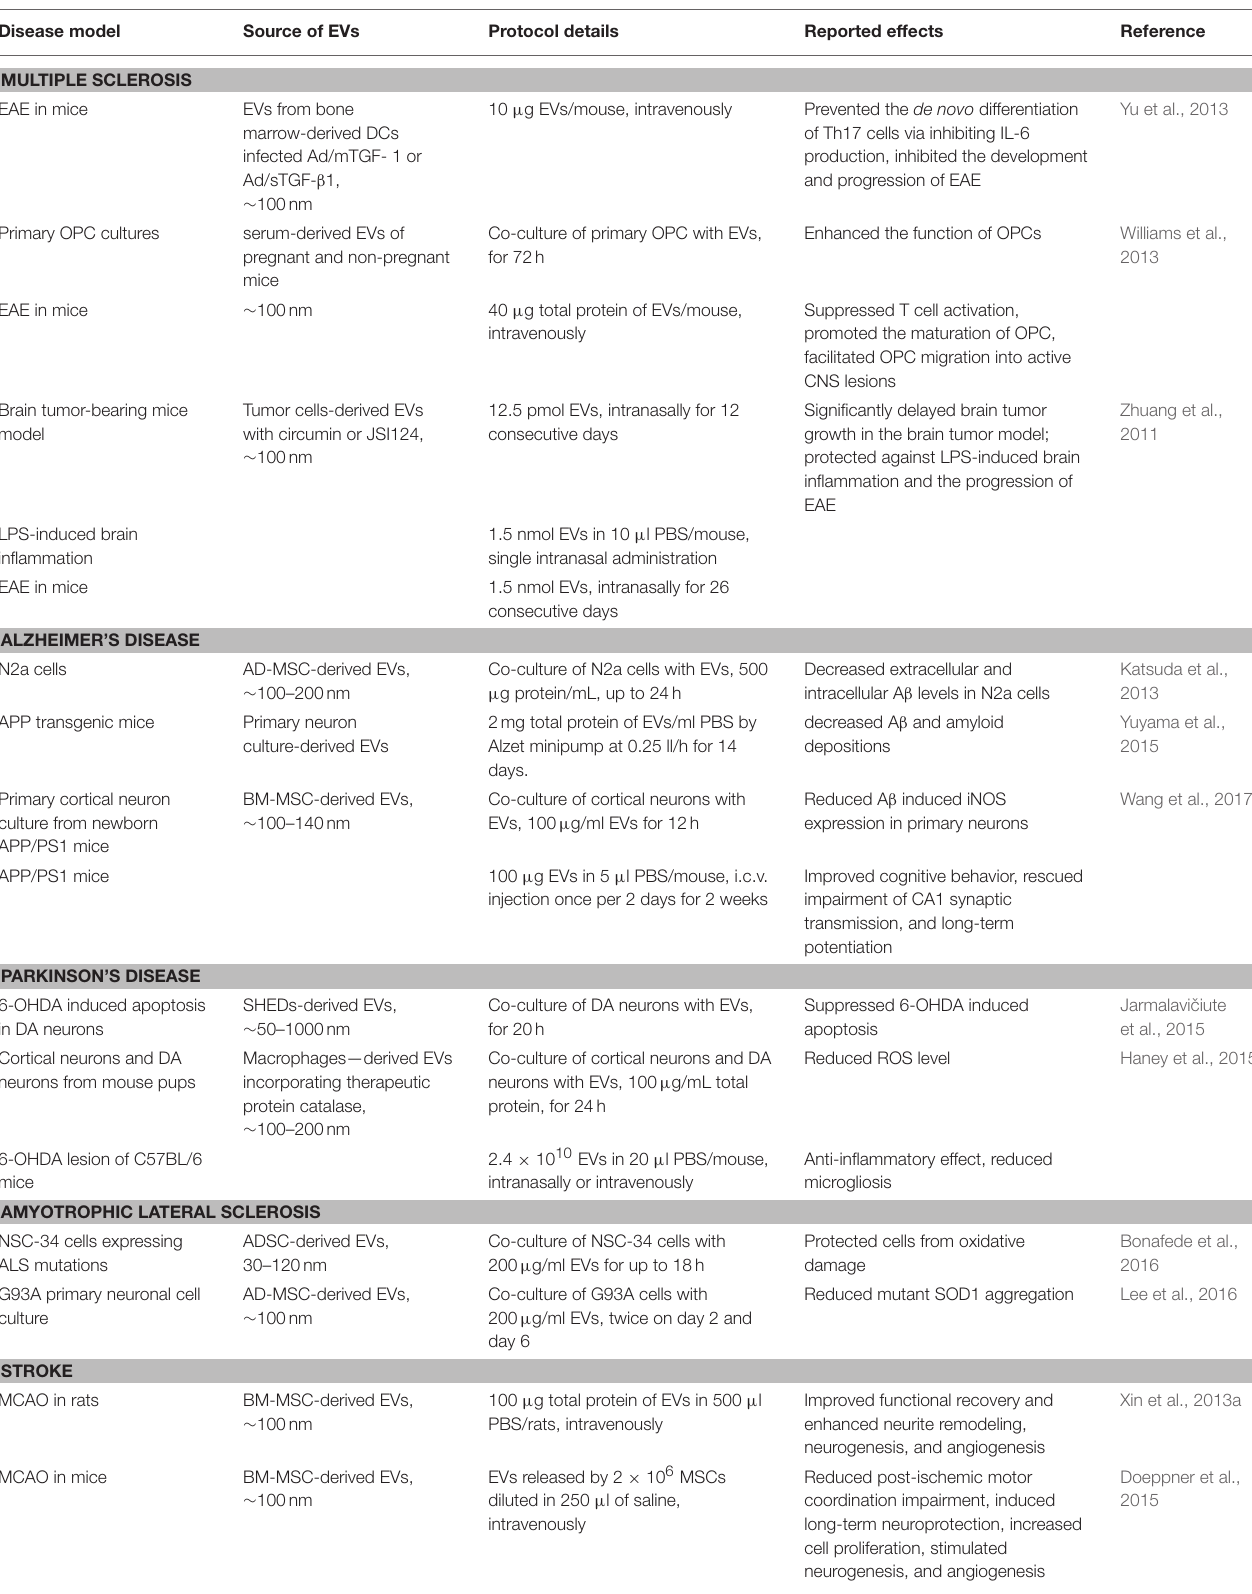
TABLE 1 | Preclinical trials using